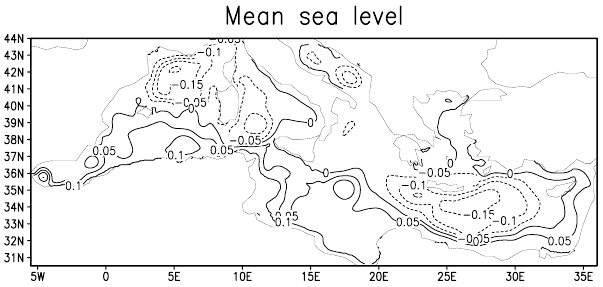
Fig. 5. Mean climatology of the sea surface height in meters, com- puted from 1993–1997 model